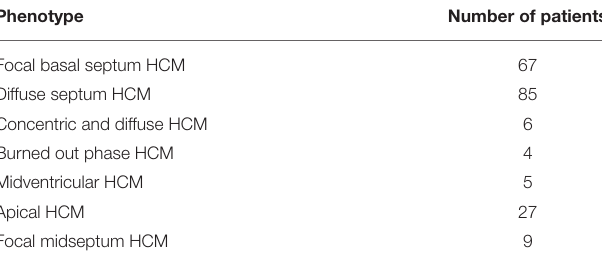
TABLE 3 | Phenotype of HCM. TABLE 4 | Correlation between SCD risk factors and global T1 mapping